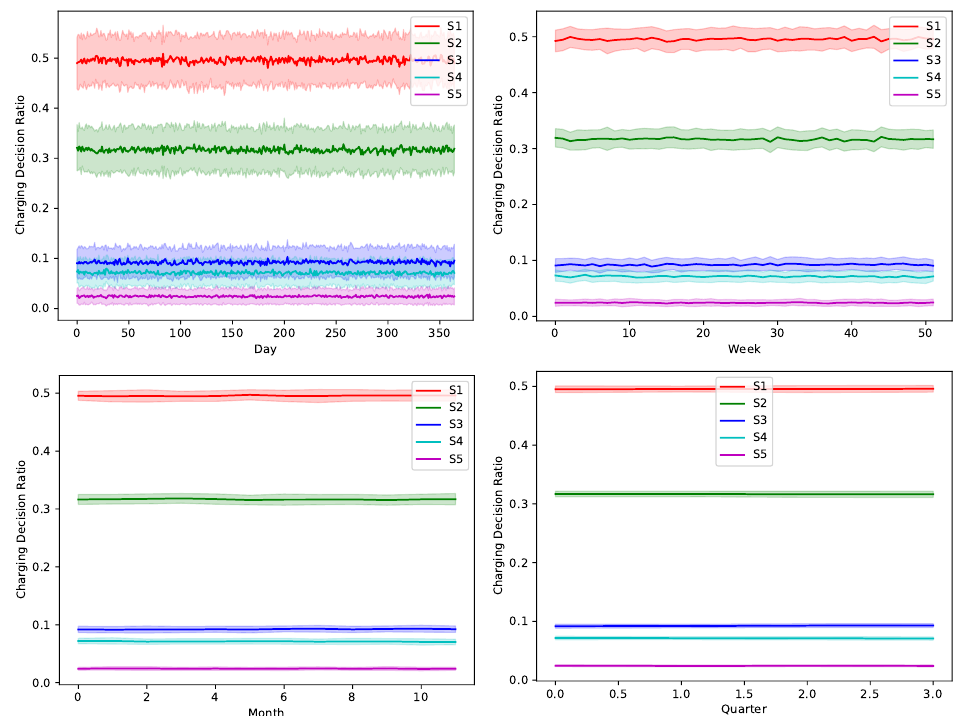
Figure 10. The temporal variation of the adopted charging decision by the greedy algorithm with a global certainty level U 50 .